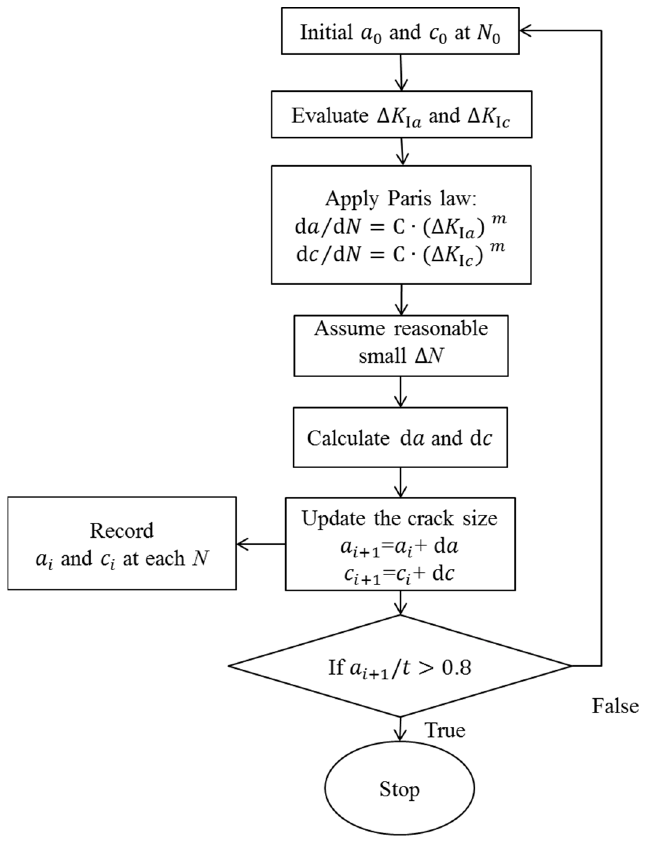
Figure 10. The procedure of evaluating surface crack growth.